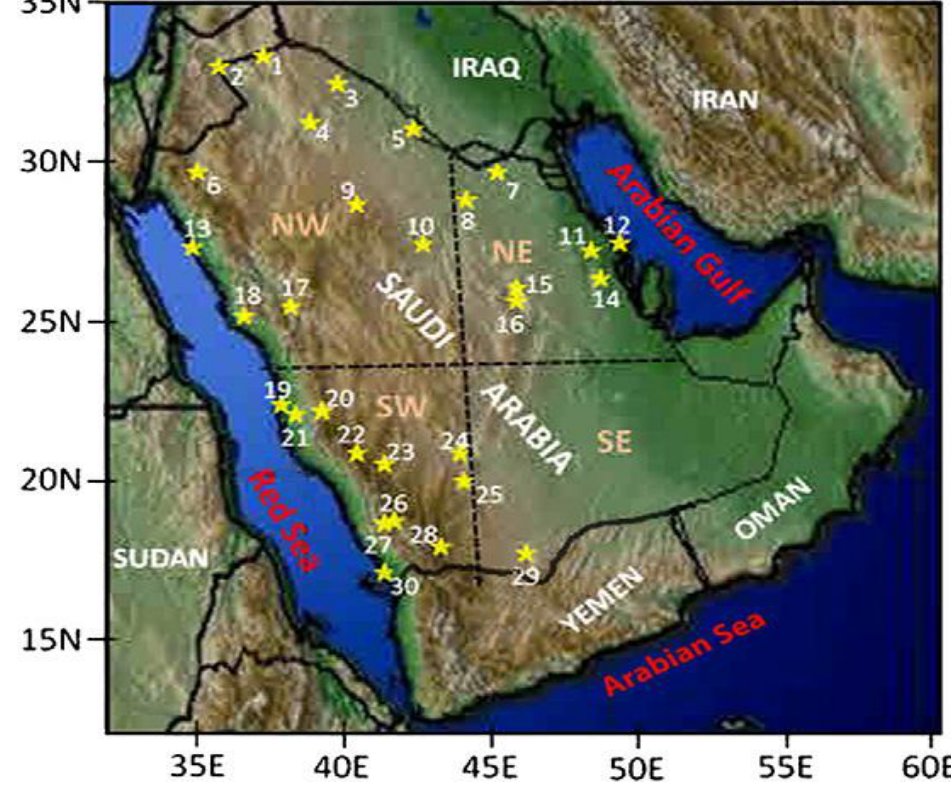
Figure 14. Rain-gauge locations over Saudi Arabia (asterisks marks). The number represents serial of observation site as per Table 3. Horizontal and vertical dashed lines make the NE, NW, SE and SW zones (counter-clockwise) used in the regional analysis